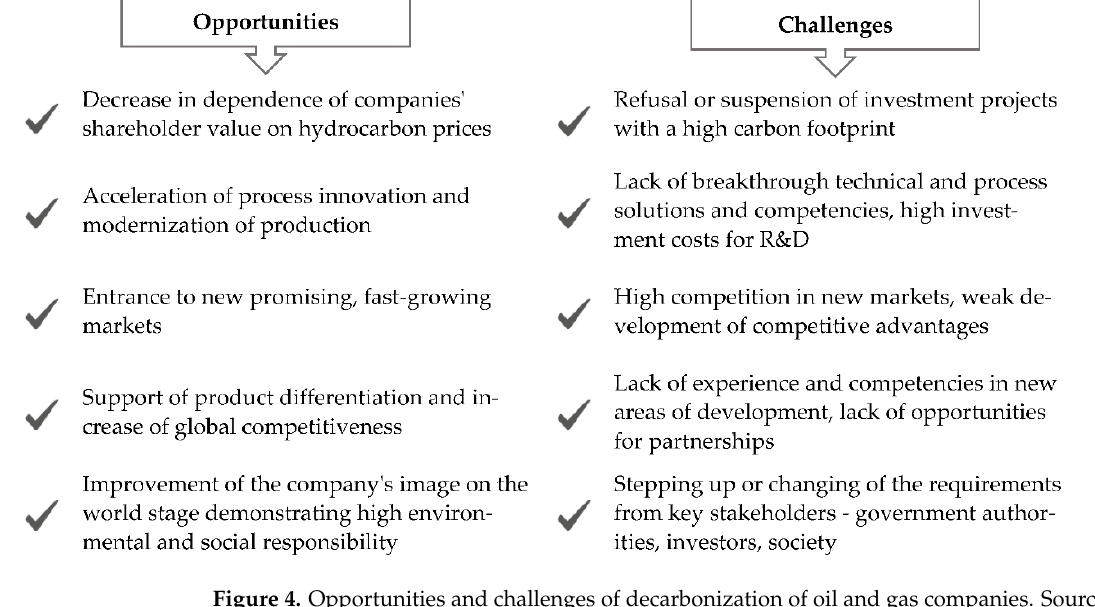
Figure 4. Opportunities and challenges of decarbonization of oil and gas companies. Source: Created by the authors.